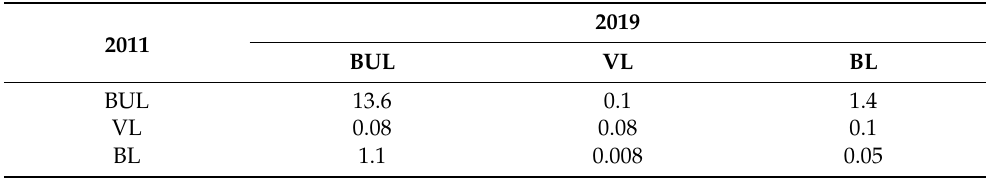
Table 5. LU/LC transition matrix between 2011 and 2019 (as a percentage) for built-Up land (BUL), vegetation land (VL), and bare land (BL)